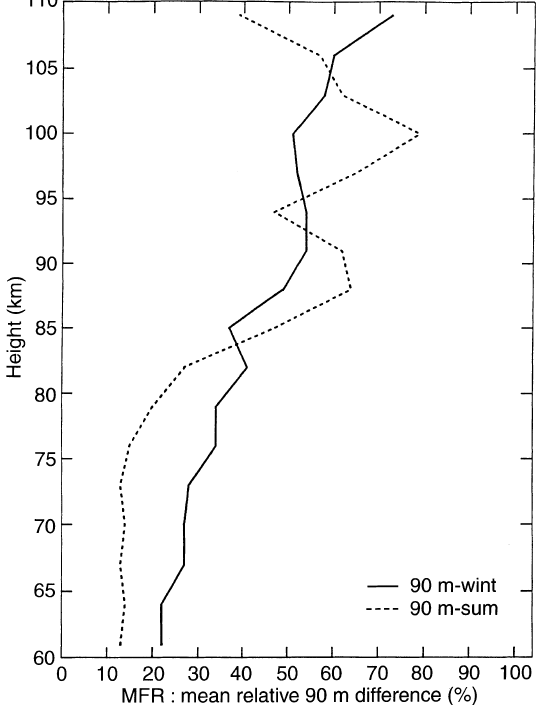
Fig. 9. Saskatoon MFR mean relative 90 min di(cid:128)erences (same data as used in Fig. 7) expressed in